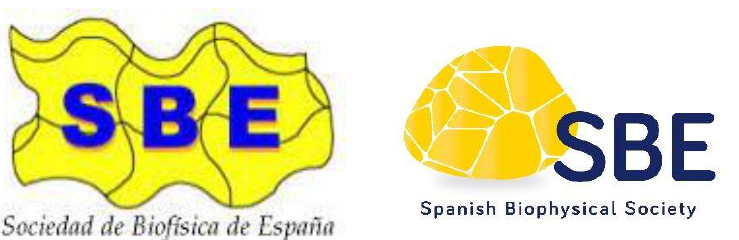
Figure 2. The 1986 and current logos of the Sociedad Biofísica de España /Spanish Biophysical Society. Funding: Fundación Biofísica Bizkaia, and the Basque Excellence Research Centre (BERC) program of the Basque Government.